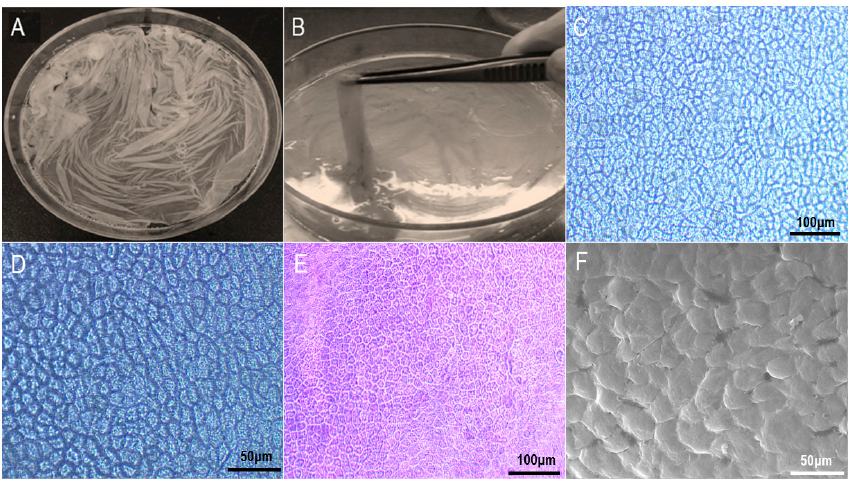
Figure 1. Fresh amniotic membrane macroscopic and microscopic observation. ( A ) Horizontal spread; ( B ) Clamp with tweezers; ( C ) Fresh AM under microscope ( × 100); ( D ) Fresh AM under microscope ( × 200); ( E ) HE staining of AM ( × 100); ( F ) SEM of fresh AM ( × 2000). The treatment time of 1% TritonX-100 combined with 0.25% trypsin/EDTA solution is long, making it easy for the amniotic membrane to deteriorate. Therefore, 5% TritonX-100 was combined with 0.25% trypsin/EDTA solution; with this step, we hoped to shorten the operation time by increasing the concentration of TritonX-100. As shown in Figure group had been shed, while the cells in the low concentration group only appeared